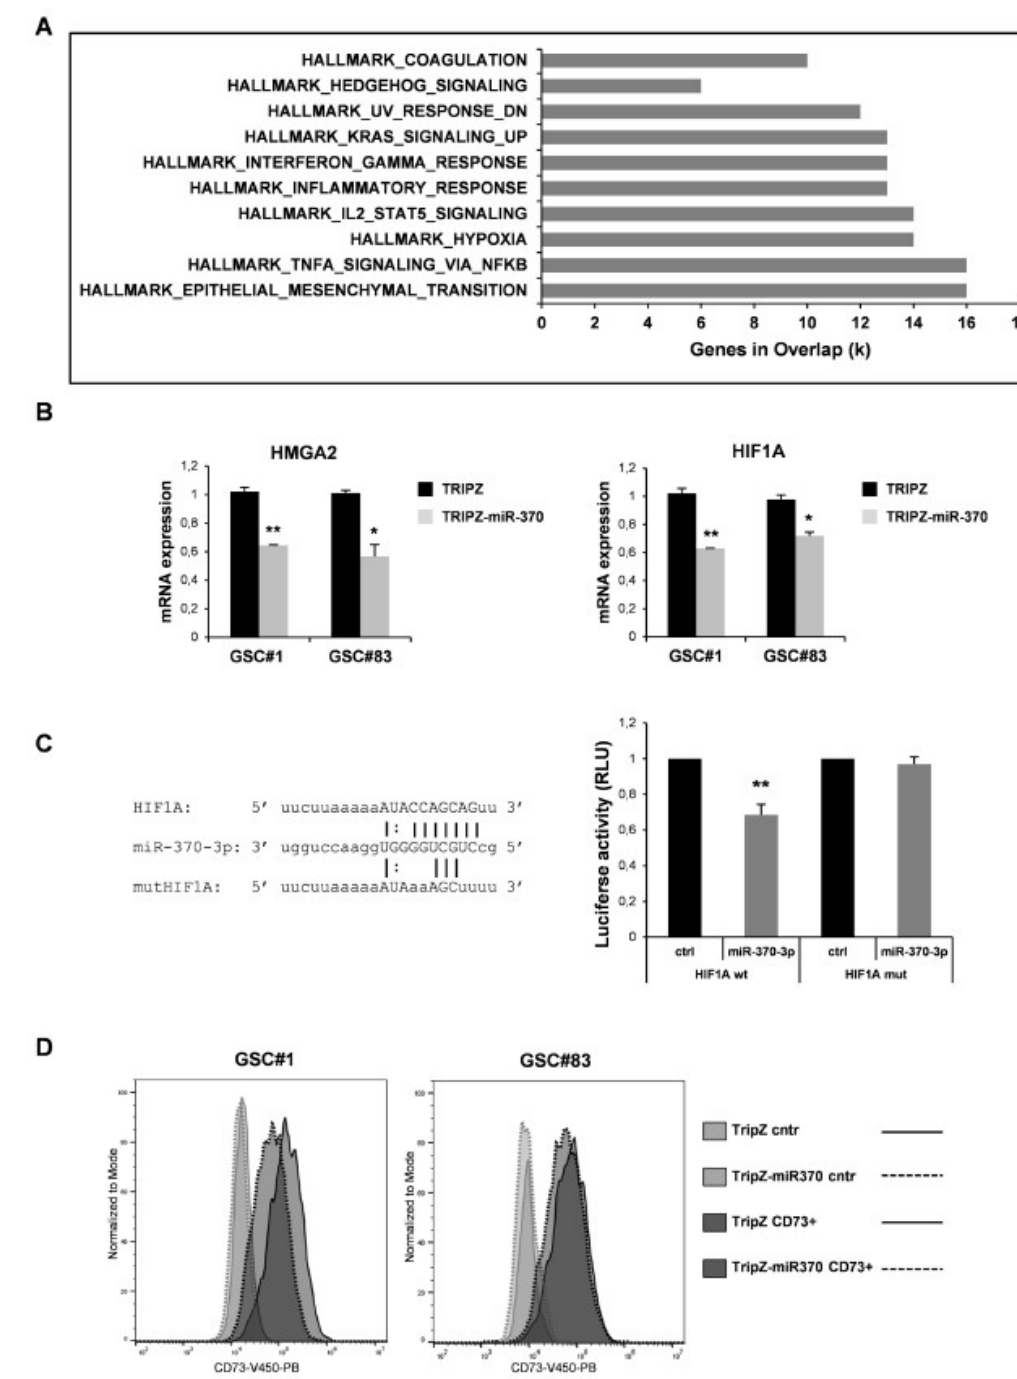
Figure 3. Effect of miR-370 restoration in GSCs. ( A ) Pathway enrichment analysis examined by GSEA software of highly modulated genes (≥2 fold both up and down) in GSC#1 transduced with TRIPZ-miR-370 vs TRIPZ empty vector. ( B ) RT-PCR analysis performed on GSC#1 and GSC#83 transduced with TRIPZ or TRIPZ-miR-370 for HMGA2 (left panel) and Hypoxia-inducible factor (HIF) 1A expression (right panel). * p < 0.05; ** p < 0.01. ( C ) Predicted binding site of miR-370-3p in the HIF1A 3′UTR sequence (left panel). Dual-luciferase reporter assay of pGL3 vectors containing the HIF1A 3′UTR or HIF1A mutant (mut), co-transfected in 293T cells with hsa-miR-370-3p-mimic or control mimic RNA (ctrl). ** p < 0.01. Histograms show normalized mean values of the relative luciferase activity. Error bars represent the mean ± SD ( n = 4) (right panel) ( D ) FACS analysis of NT5E/CD73 on GSC#1 and GSC#83 transduced with TRIPZ empty vector and TRIPZ-miR-370 after doxycycline